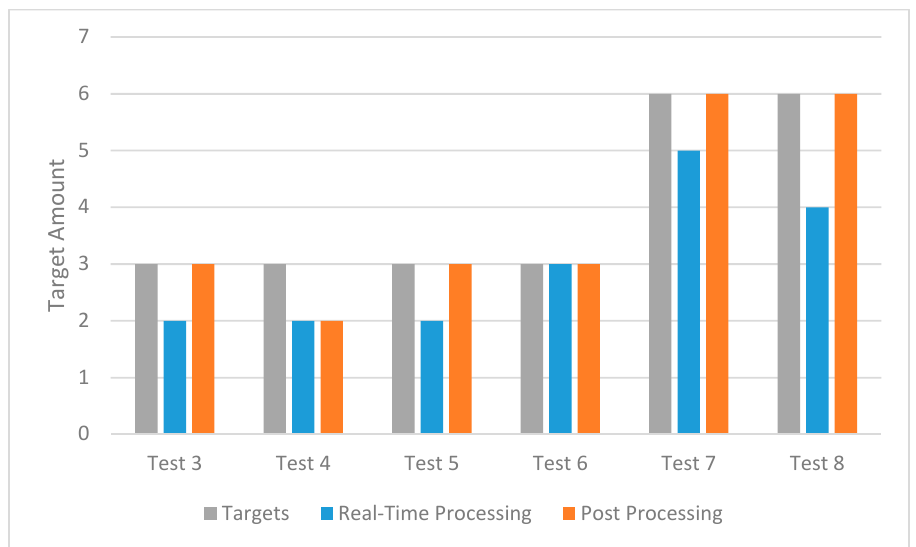
Figure 24. Target identification results of real-time processing and post-processing.